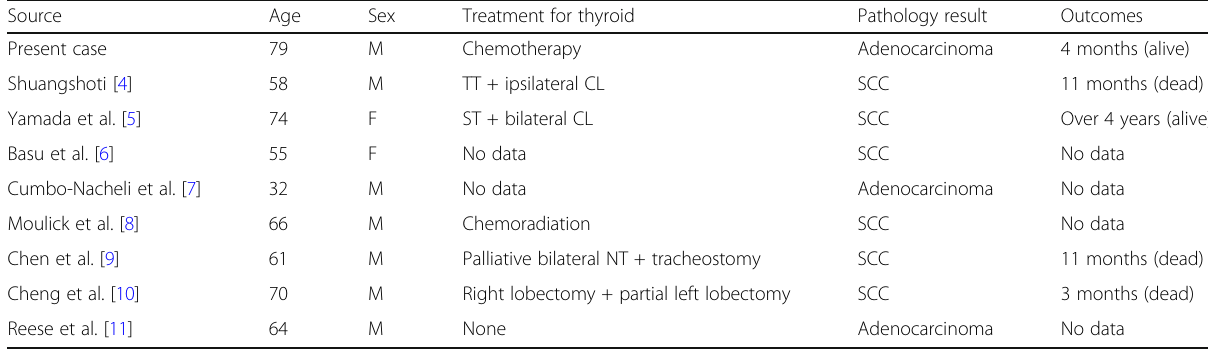
Table 1 The literature review of cases with thyroid metastasis from esophageal cancer Source Age Sex Treatment for